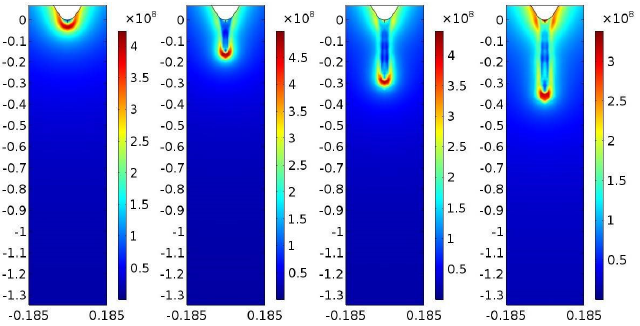
Figure 7. Positive streamer propagation. Evolution of the electric field (V/m) in nanofluids with τ np = 20 ns along the z -axis, applying 300 kV and with a rise time of 10 ns.